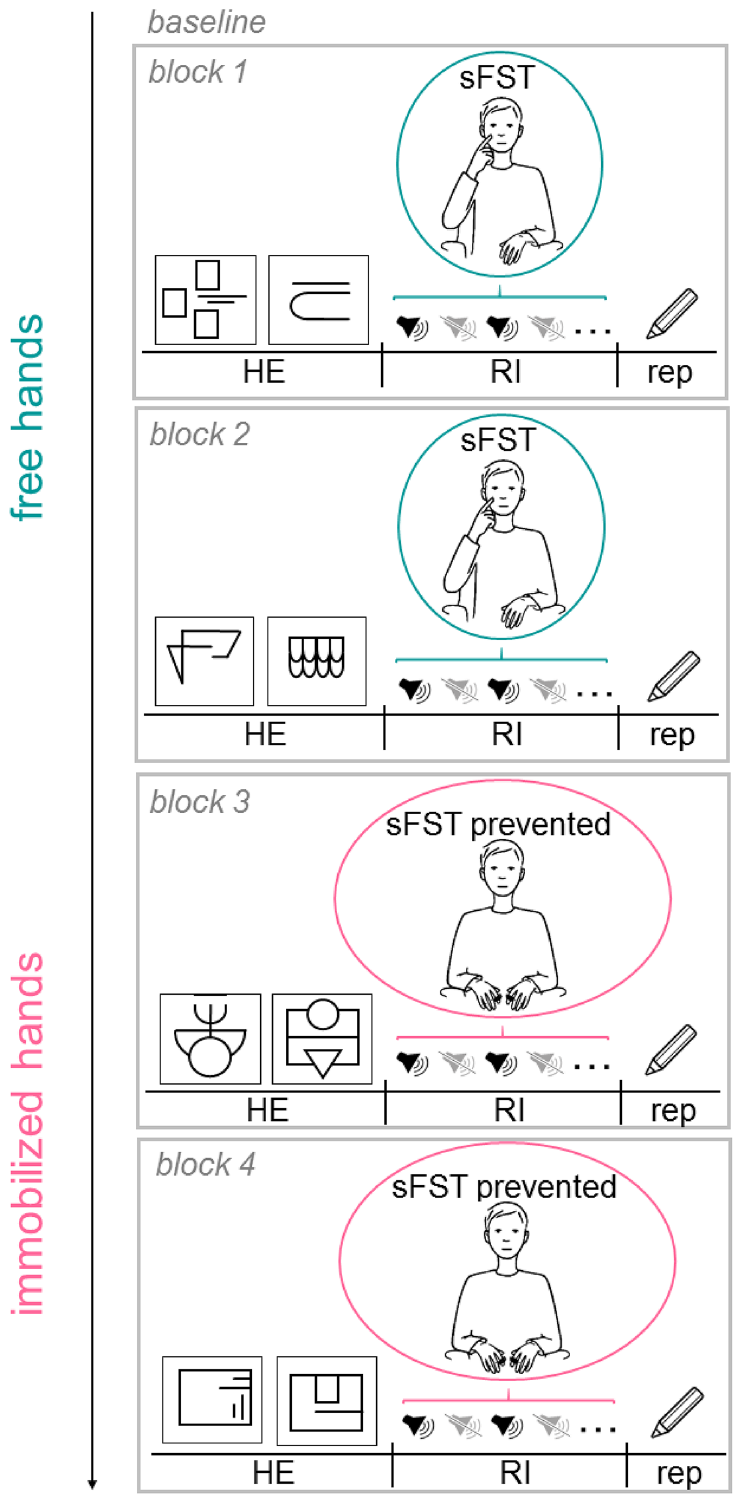
Figure 1. Schematic representation of the course of the experiment. After three minutes of rest (baseline, eyes open), two haptic reliefs had to be explored manually (HE) and subsequently remembered for a retention interval (RI) of 14 min. During the RI, a total of 40 distracting sounds alternated with 40 sound-free phases. After the RI, participants were asked to reproduce (rep) the remembered stimuli on a sheet of paper. After the first block (block 1) the procedure was repeated a second time (block 2). In the “free hands” condition (block 1&2), participants were able to exhibit spontaneous facial self-touches sFST during the RI. In the “immobilized hands” condition (block 3&4), the participants’ fingers were loosely fixed during the RI. Thus, the performance of sFST was suppressed. The order of conditions was randomized. Each block consisted of two different relief stimuli. Stimuli were randomized between